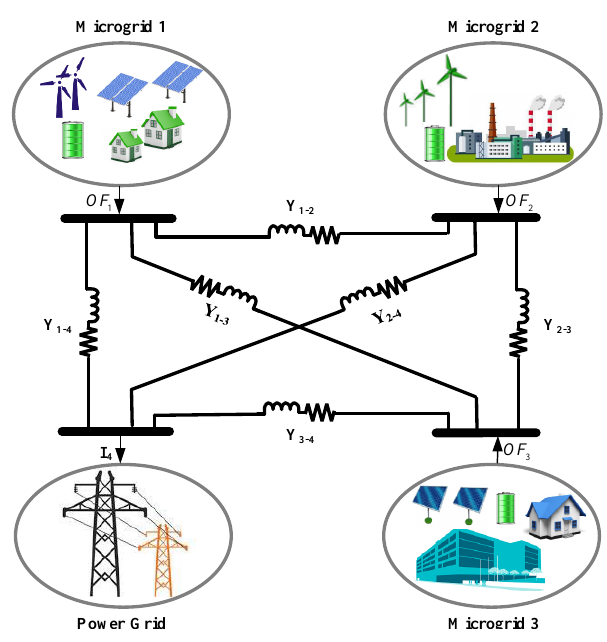
Figure 2. An illustrative four-bus network